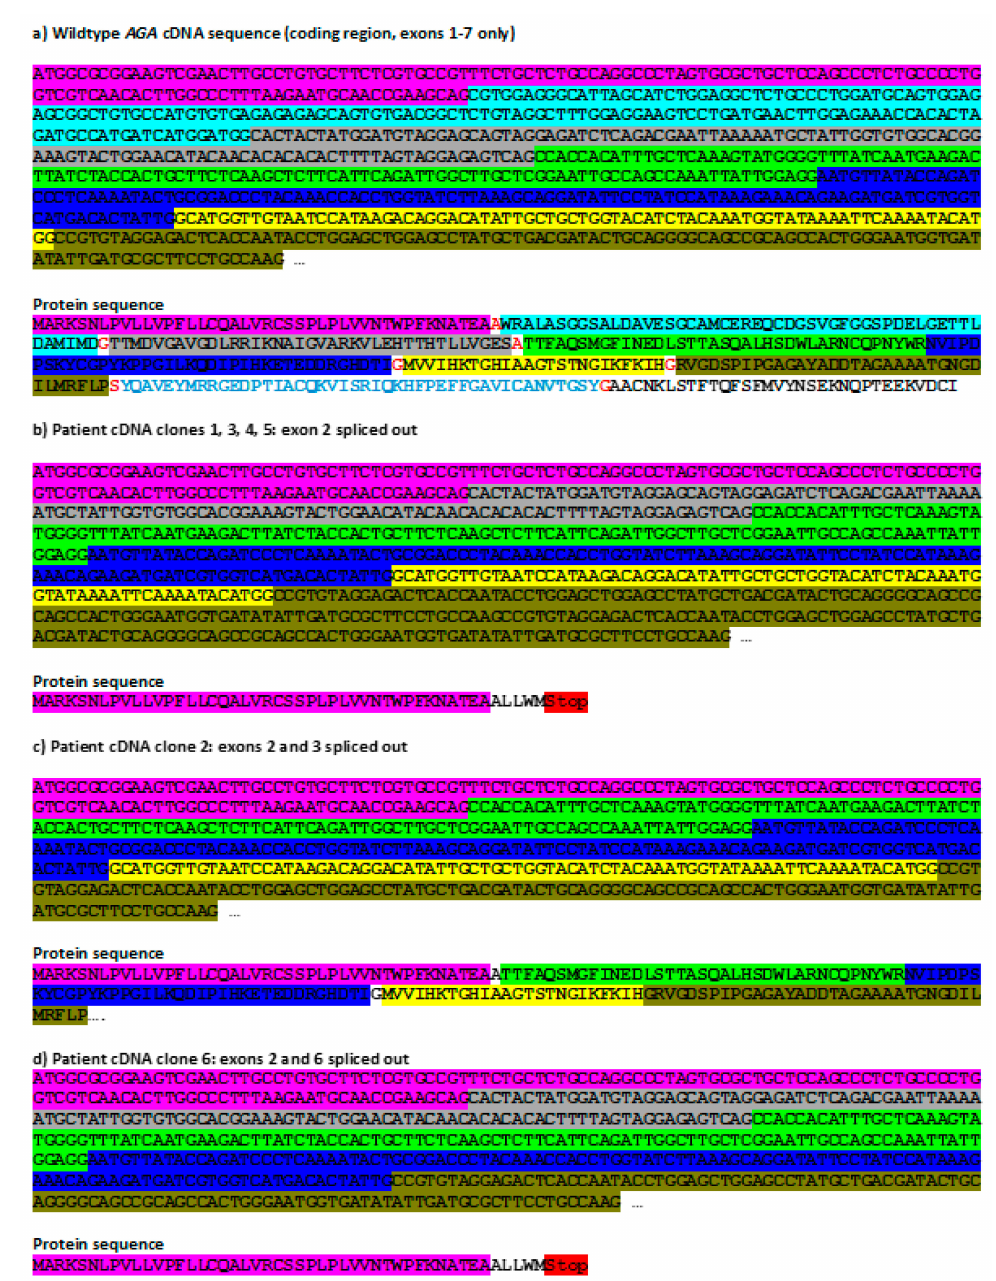
Figure 3. Sequence analysis of cloned AGA cDNAs from patient fibroblasts with the c.128-2A>G variant. ( a ) AGA reference coding sequence (NM_000027.4) and translation thereof. Individual exons are shown in different colors. The codons for the amino acids in red (wildtype protein sequence) at the borders of two exons contain bases from both exons. ( b – d ) Total RNA was isolated from patient fibroblasts, reversely transcribed into cDNA, and the AGA coding region was amplified by standard PCR. The products were cloned into pcDNA3 and six clones were sequenced. In all cases, exon 2 was missing, either alone ( b ) or in combination with exon 3 ( c ) or exon 6 ( d ). Mis-splicing leads either to introduction of an early stop codon ( b , d ) or an in-frame deletion of 89 amino acids ( c